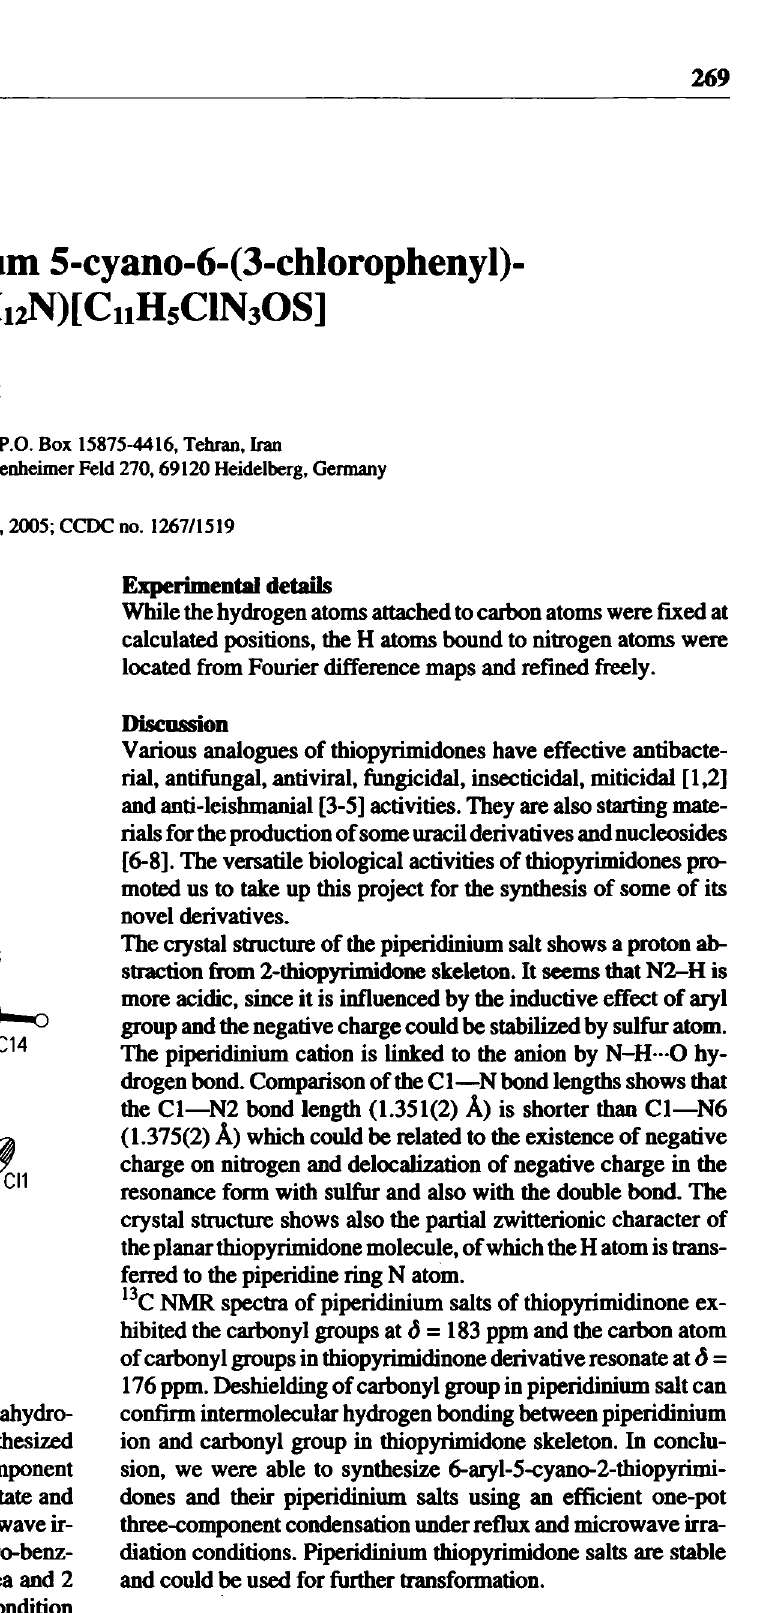
Table 1. Data collection and